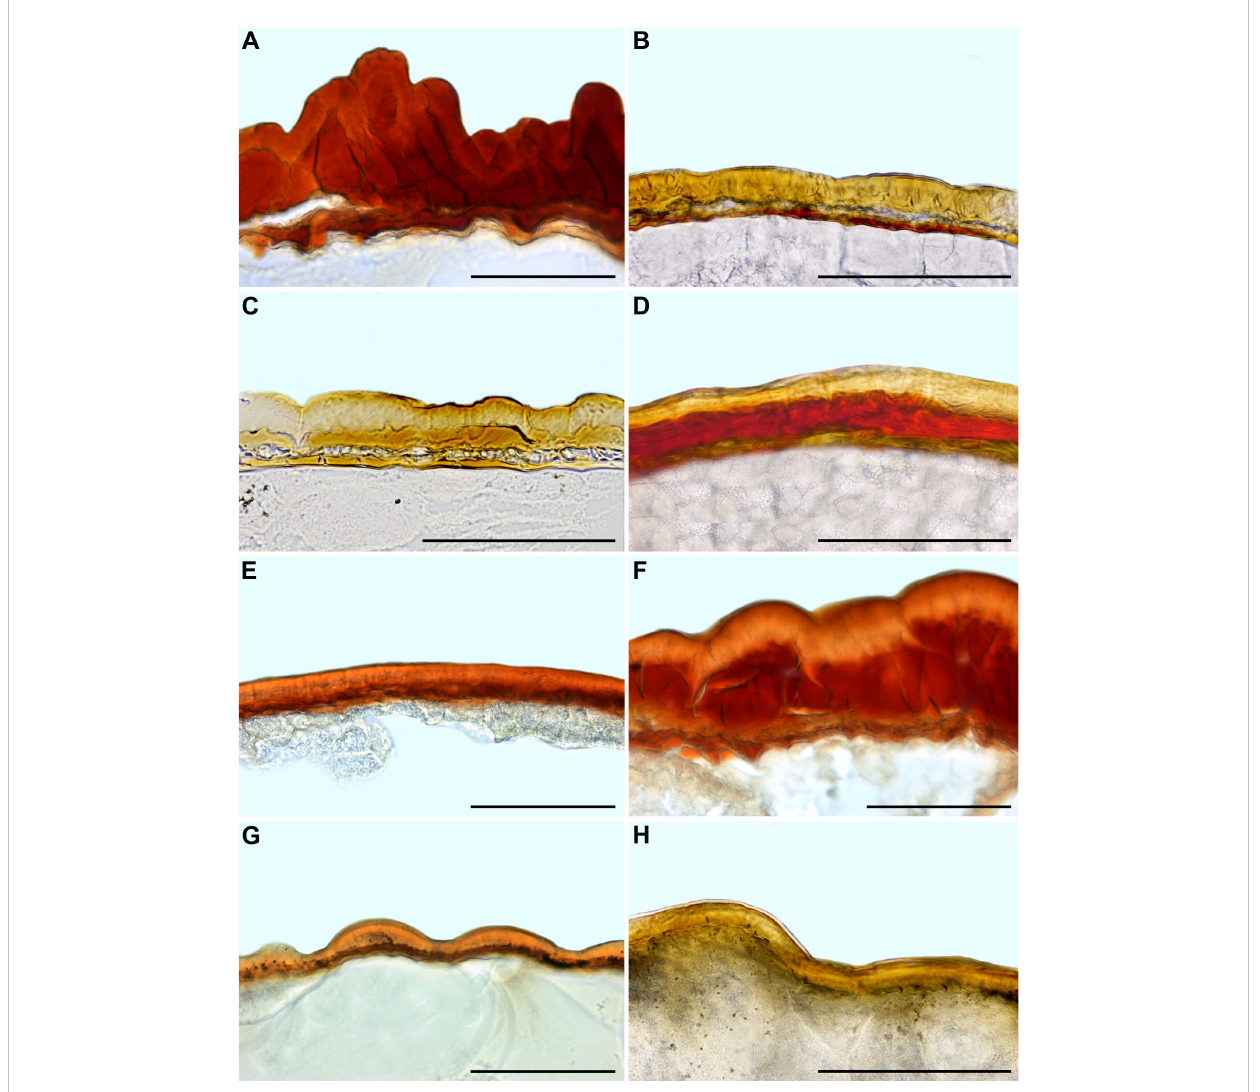
FIGURE 9 Seed coat cross-sections of selected Acrosanthoideae (A) and Ruschioideae (B – H) species. (A) Acrosanthes anceps , (B) Apatesia helianthoides , (C) Carpanthea pomeridiana , (D) Hymenogyne glabra , (E) Conicosia elongata , (F) Skiatophytum tripolium , (G) Cleretum bruynsii , (H) Cleretum bellidiforme . Scale bar – 100